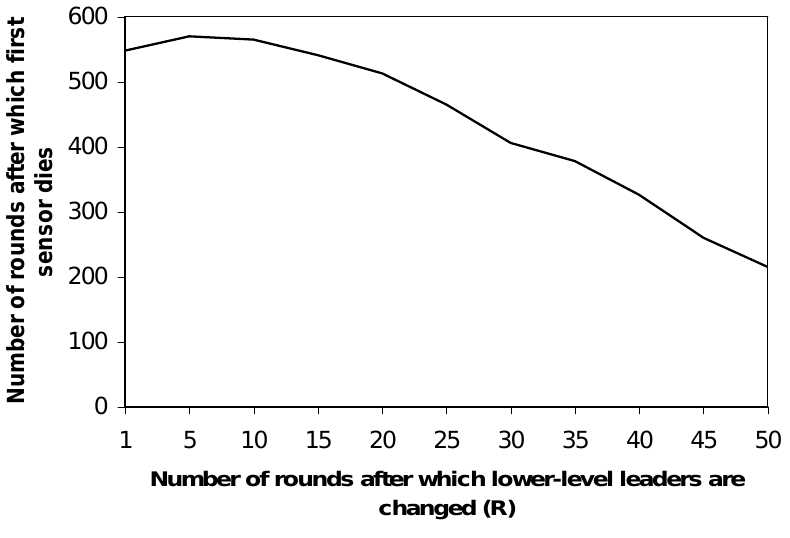
Figure 14. Leader selection time vs . network lifetime.